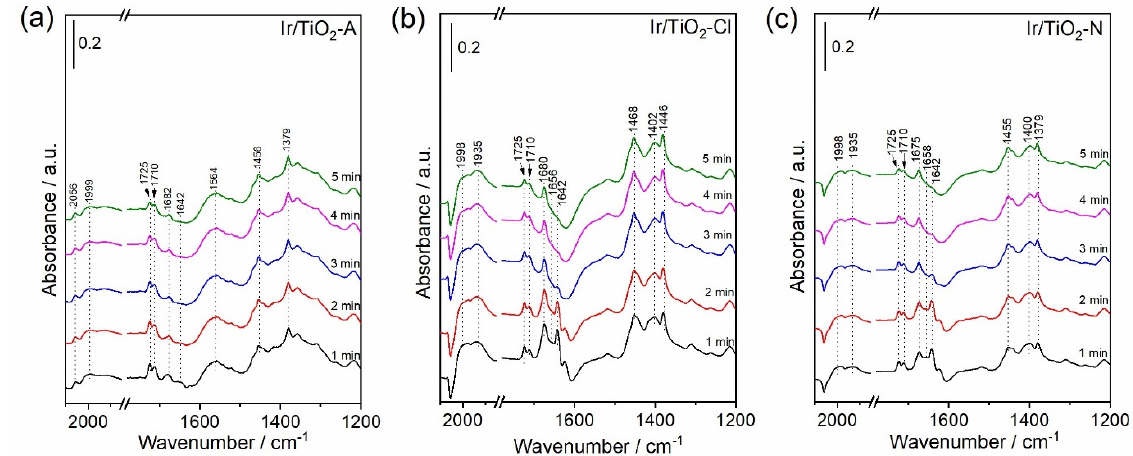
Figure 7. In situ FTIR spectra of CRAL hydrogenation reaction at 30 °C over the pre-reduced Ir/TiO 2 catalysts in region of 1200–2100 cm − 1 .